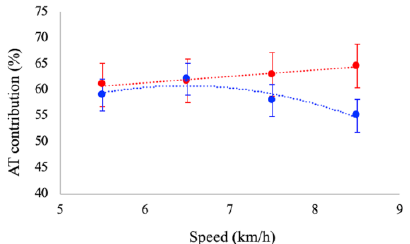
Figure 2. Contribution of the Achilles tendon power to the total mechanical power generated by the GM MTU during walking (blue dots) and running (red dots) at the investigated speeds. Data are means ±SD.